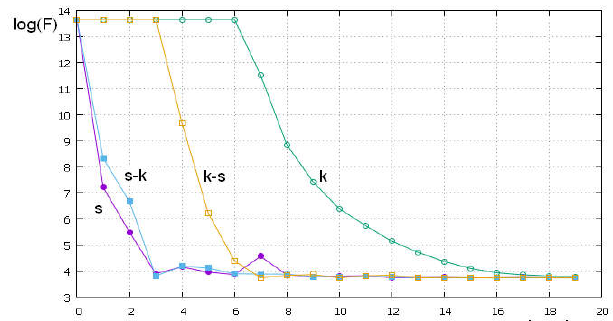
Figure . Dependences of an algorithm convergence on number of